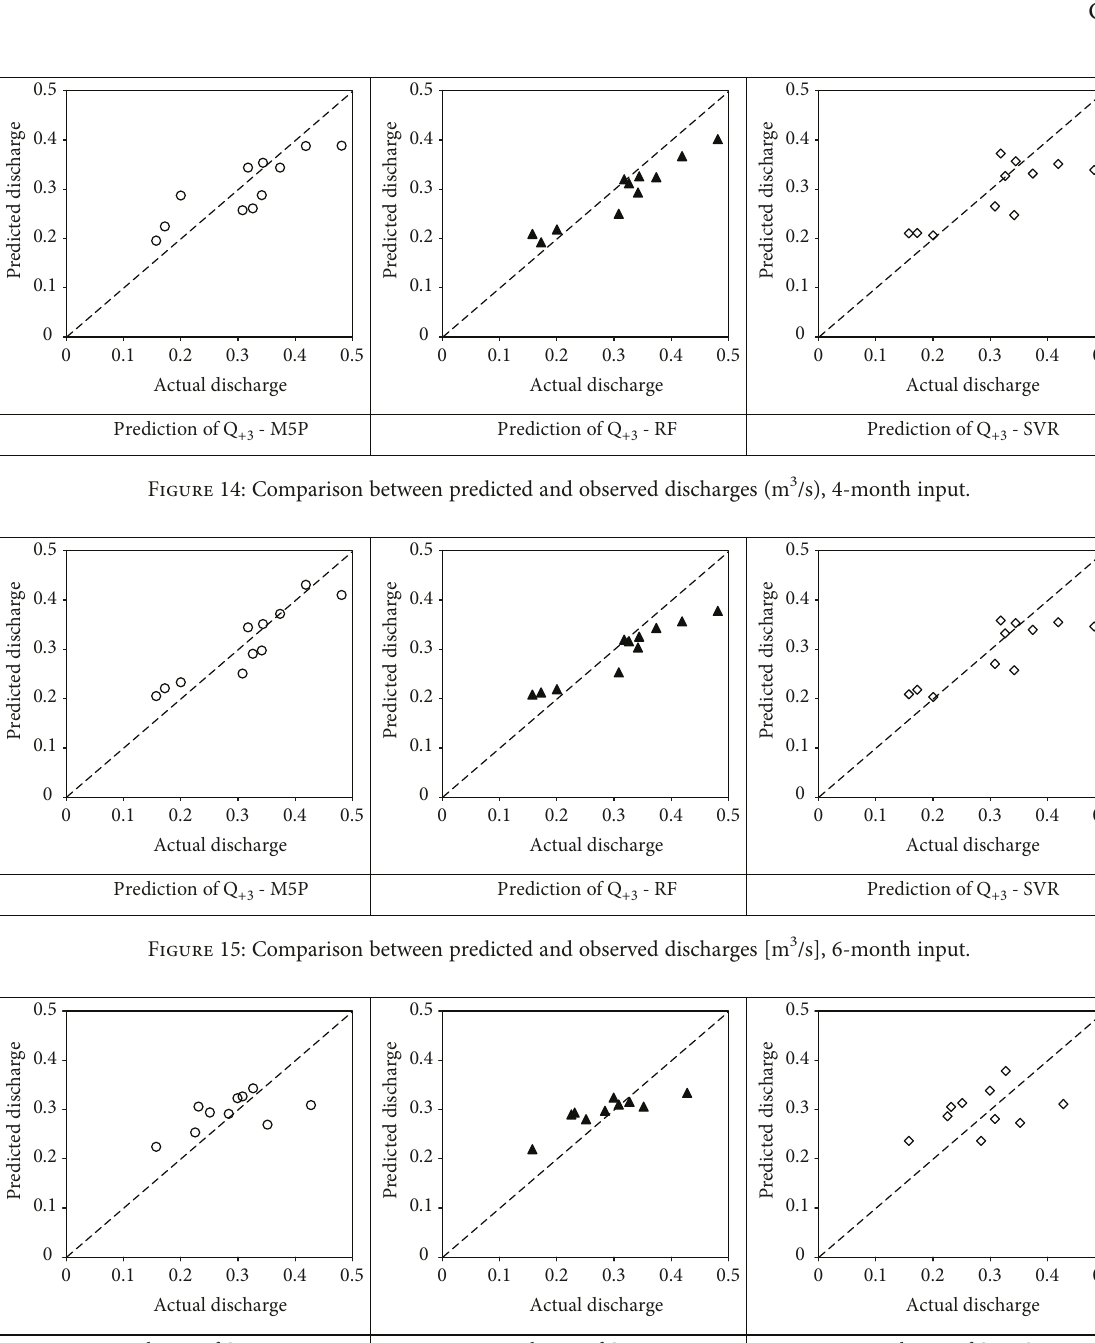
Prediction of Q + 3 - M5P Prediction of Q + 3 - RF Prediction of Q + 3 - Figure 16: Comparison between predicted and observed discharges (m 3 /s), 8-month